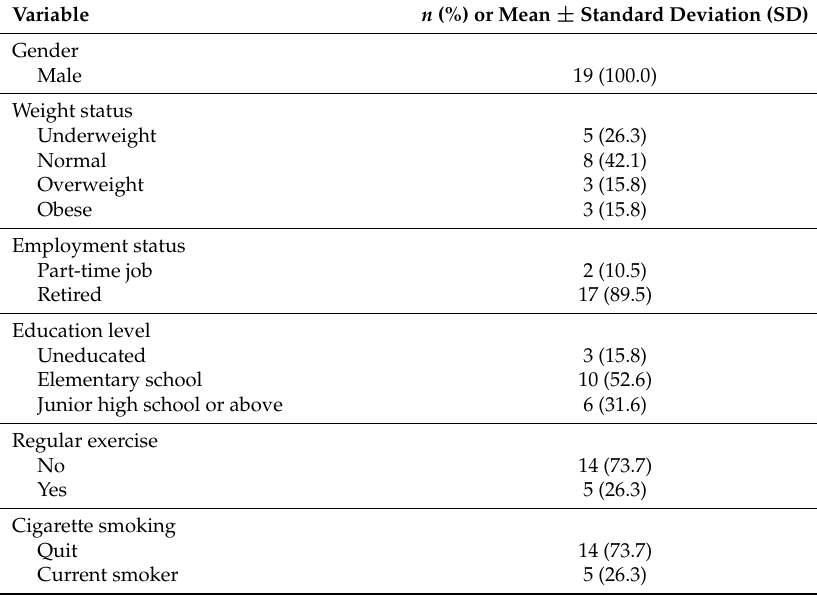
Table 1. Demographic and clinical characteristics of the study participants ( n =